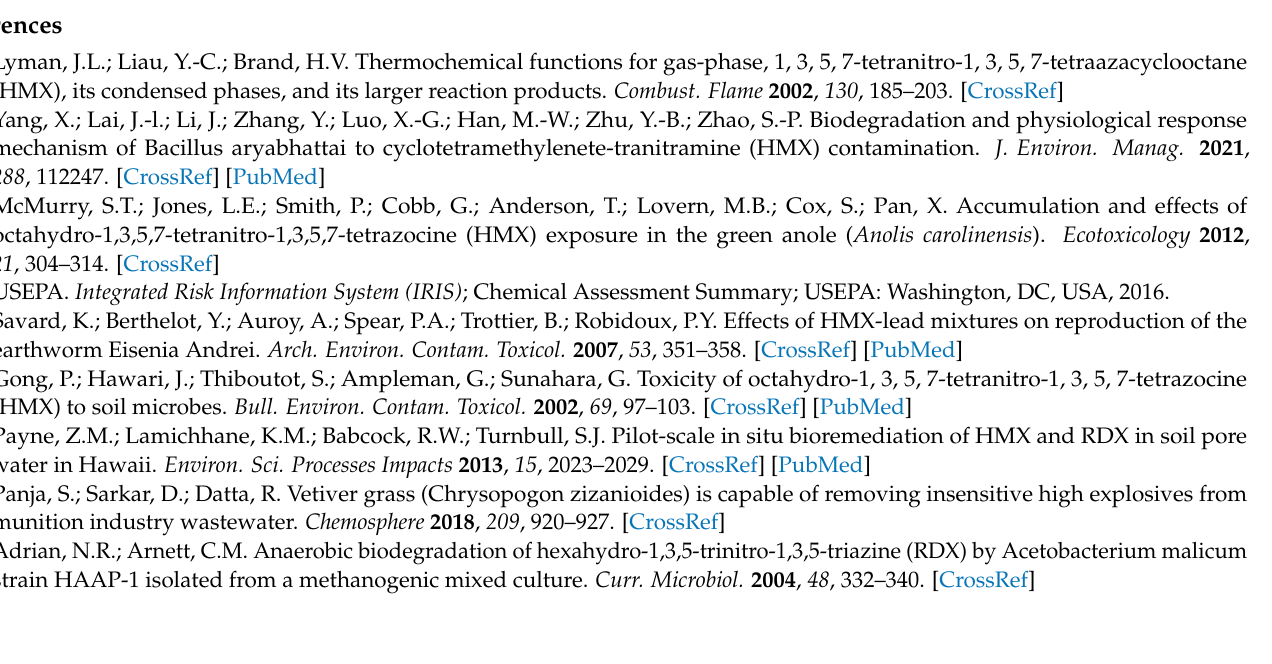
under optimal conditions in the presence of different TBA concentrations; Figure S4: The number of genes showing altered expression (TELI gene > 1.5) during the electrochemical oxidation of HMX; Figure S5: Hierarchical cluster (HCL) analysis diagram based on differential gene expressions (mean lnI, n = 3) of 114 selected stress genes in E . coli in exposure to the HMX samples at different times (Red colors indicate up-regulation, green colors indicate down-regulation); Table S1: Kinetics and energy consumption of HMX degradation under different operating conditions.; Table S2. Main degradation intermediates of HMX; Table S3: Stress gene bank and its main functions; Table S4: Single-factor experimental